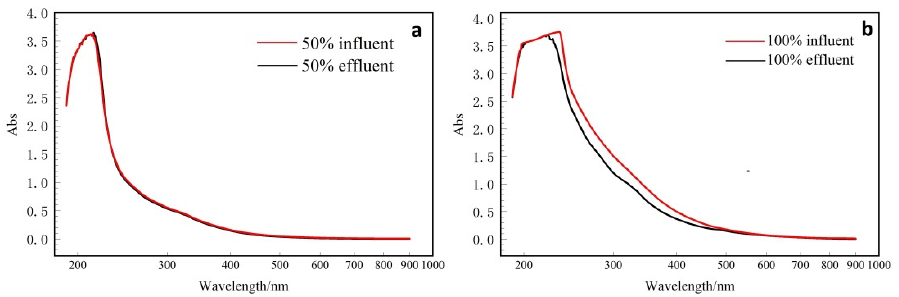
Figure 1. Results of the UV-Vis analysis for the influent and effluent in the acclimation system. (The proportion of SBECW in the influent and effluent was 50% ( a ); The proportion of SBECW in the influent and effluent was 100% ( b )).